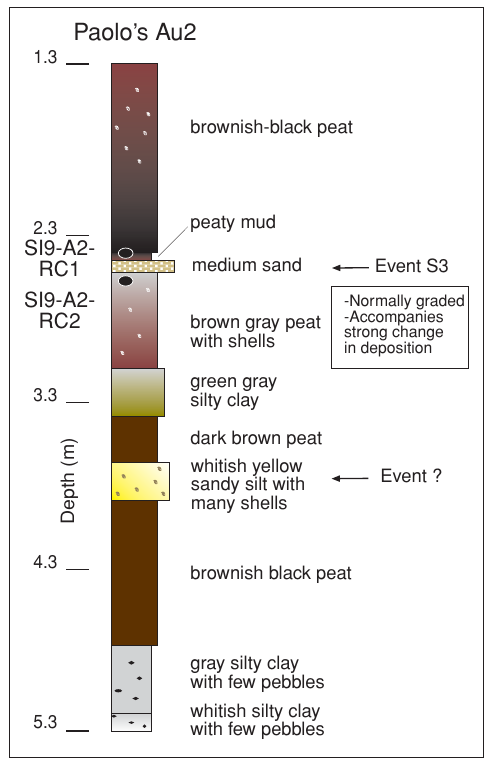
Fig. 12. Core Paolo’s AU2 log from Siponto area. The location of two charcoal samples is also plotted with a black